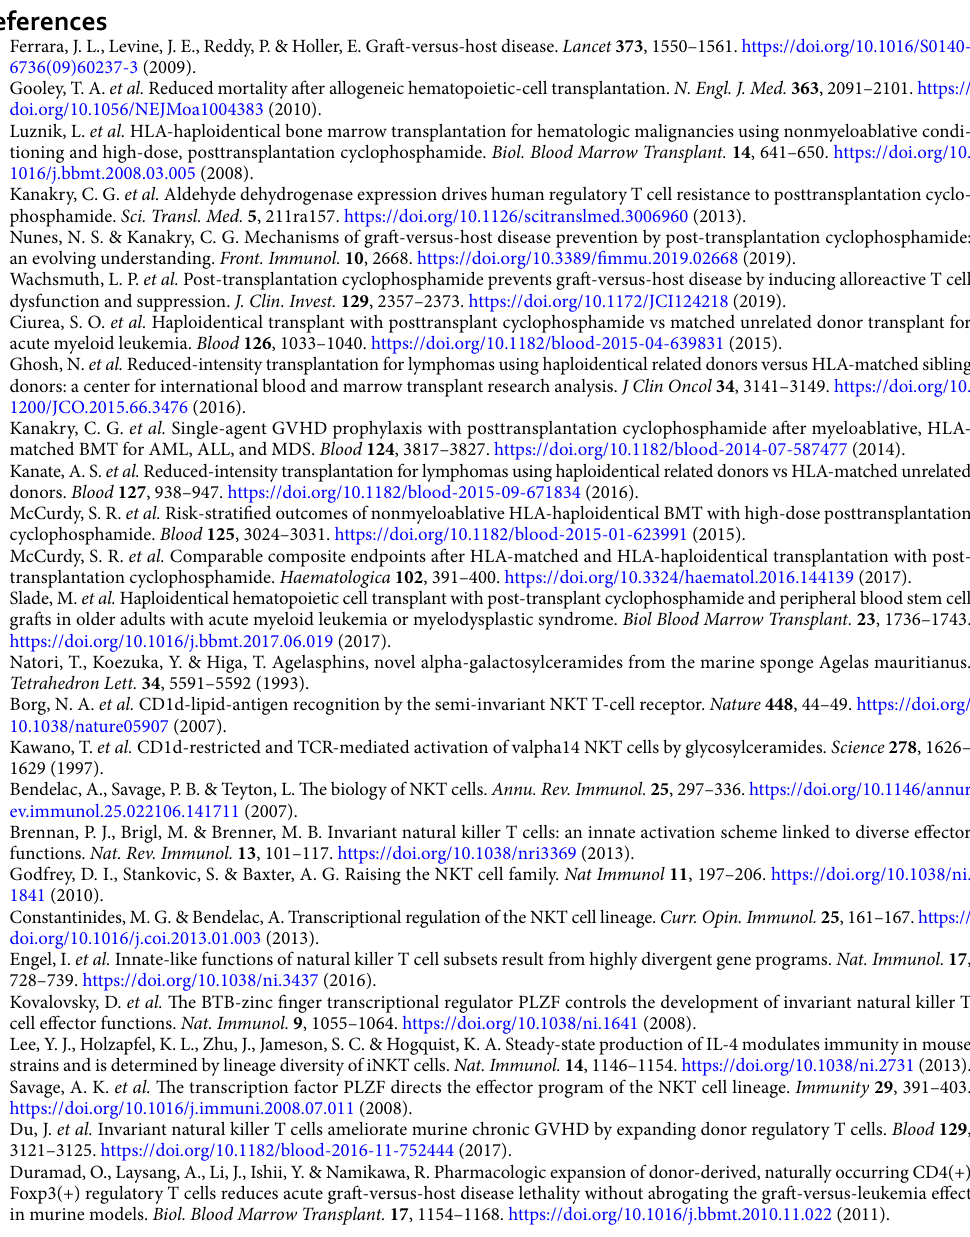
Figure 7. Lipo α-GC enhances the expansion of donor-derived Tregs. ( a ) Experimental scheme: 5 × 10 6 TCD-BM cells from B6 (H-2K b CD45.2 + ) donor mice and 10 × 10 6 splenocytes from Ly5.1-B6 (H-2K b CD45.1 + ) donor mice were administered to lethally irradiated B6D2F1 (H-2 Kb /d , CD45.2 + ) recipient mice. A reduced dose of 25 mg/kg cyclophosphamide or control vehicle was administered on day 3, followed by lipo α-GC administration on days 3, 5, and 7 after BMT. ( b ) Representative data from a flow cytometric analysis show Tregs (CD4 + Foxp3 + CD25 + ), Tcons (CD4 + Foxp3 − ) and CD8 + T cells in the splenocyte population and the associated chimerism after BMT in the vehicle (n = 7), reduced PTCy (n = 8) and lipo α-GC plus reduced PTCy (n = 7) groups. ( c ) Flow cytometric analysis of mLN cells on day 14 after BMT revealed the absolute numbers of Tcons, CD8 + T cells and Tregs and percentages of Tregs. ( d ) Flow cytometric analysis of splenocytes on day 28 after BMT revealed the absolute numbers of Tcons, CD8 + T cells and Tregs and percentages of Tregs. ( e , f ) Flow cytometric analysis of splenocytes on day 14 after BMT revealed the chimerism of Tcons and Tregs. ( g , h ) Flow cytometric analysis of splenocytes on day 28 after BMT revealed the chimerism of Tcons and Tregs. P values were determined by one-way ANOVA and Tukey’s adjustment for multiple comparisons. * P < 0.05; ** P < 0.01; *** P < 0.001; **** P <